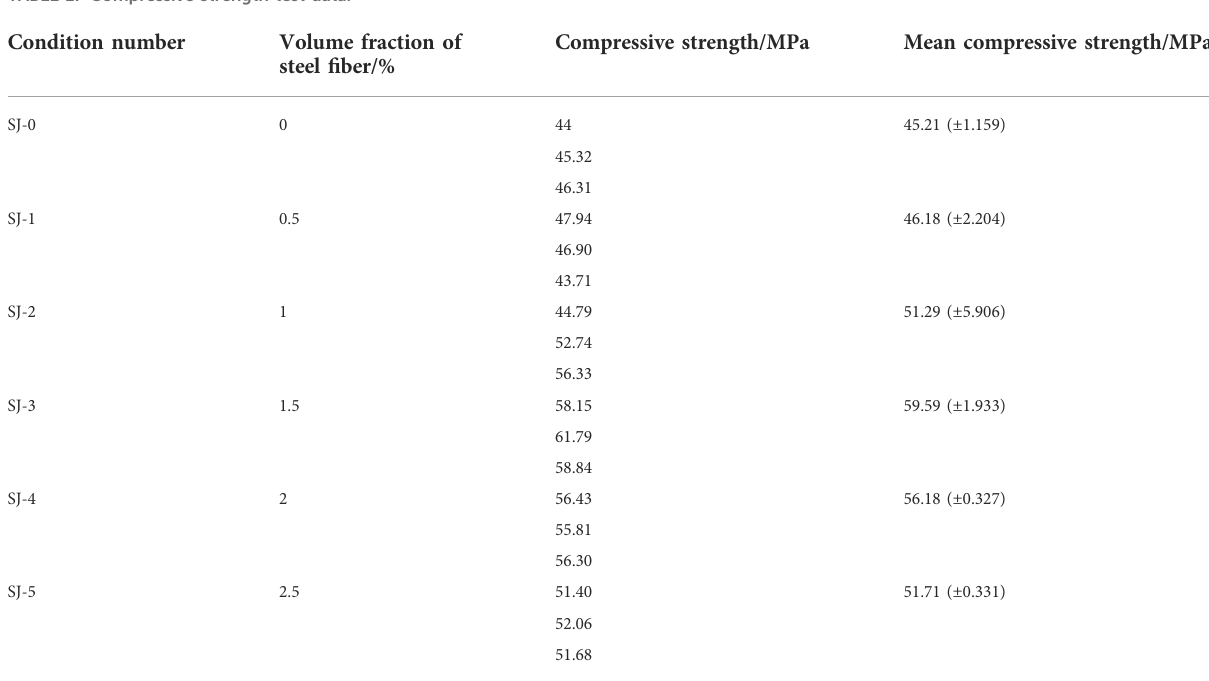
TABLE 17 Compressive strength test